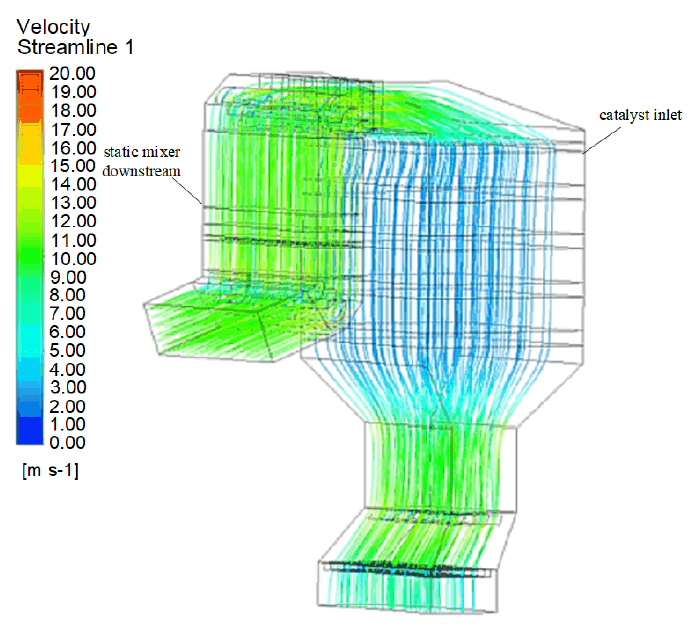
Figure 4. Streamline diagram of original